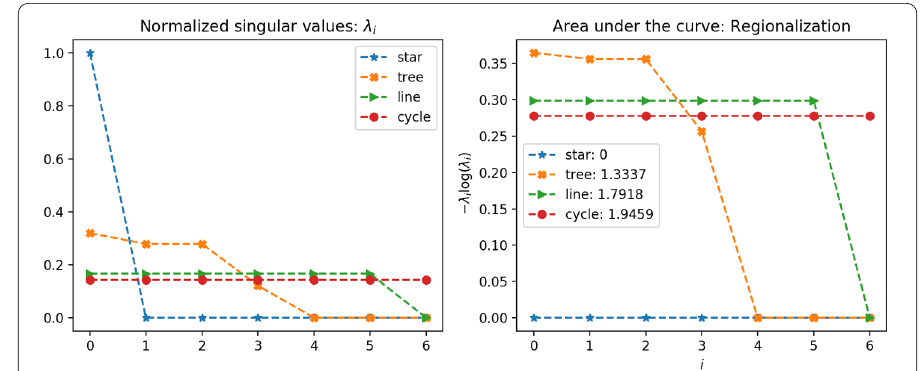
Figure 1 An example computation of the regionalization index ( χ ( G )) across a set simple, stylized graphs. On the left, we show the normalized list plot of singular values of a star (blue-star), tree (orange-cross), line (green-triangle) and cycle (red-circle) graph with seven nodes each. On the right, we show the entropy list plot for each graph, i.e., the normalized singular values, and χ ( G ) is exactly the area under this curve (corresponding to values as listed in the